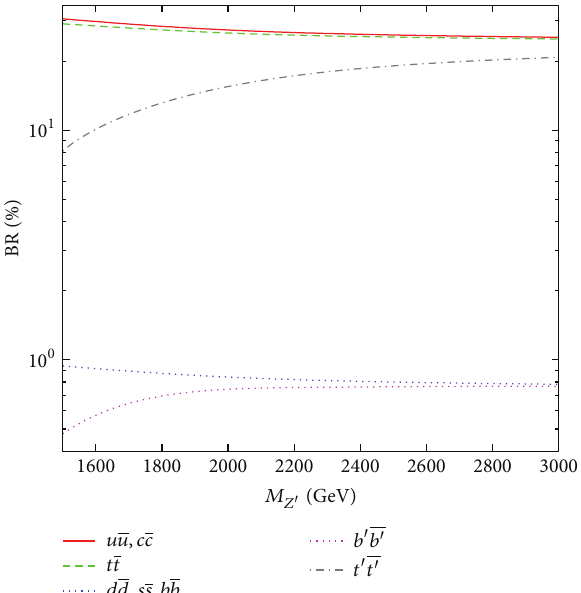
Figure 8: Branching ratios (%) depending on the mass of 𝑍 󸀠 boson for diagonal couplings to quarks within the 𝑍 󸀠 LP model. The new heavy quark masses are taken to be 700 GeV.